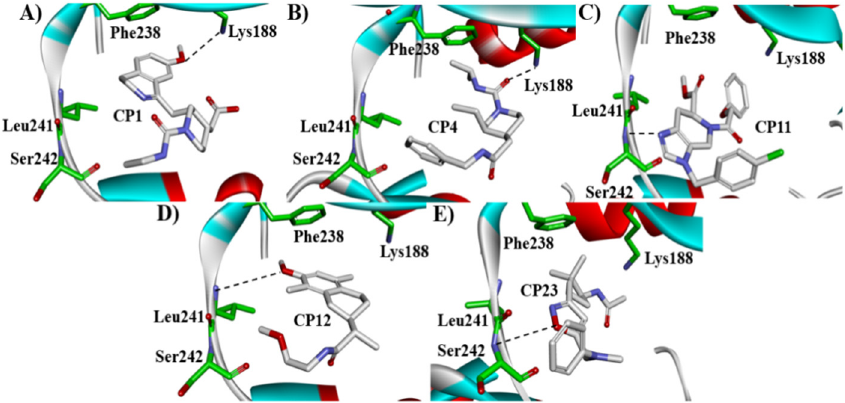
Figure 5. Predicted binding modes of five theoretical hits, ( A ) CP1, ( B ) CP4, ( C ) CP11, ( D ) CP12 and ( E ) CP23 with DYRK1A.